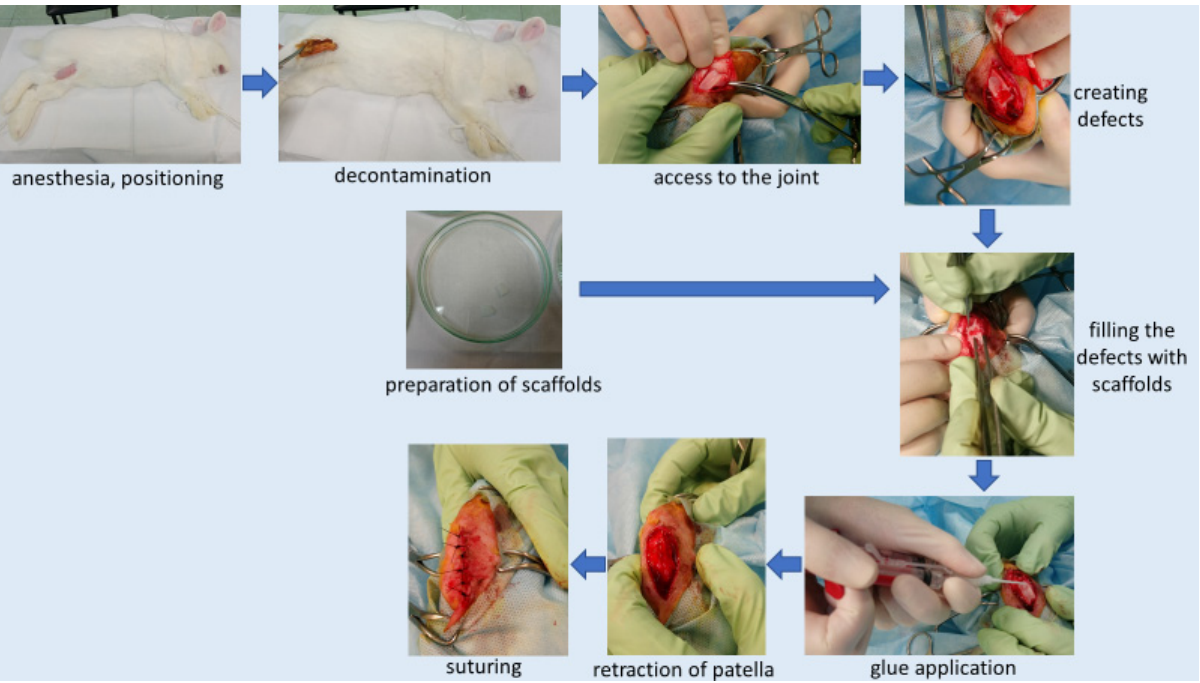
Figure 3. Implantation